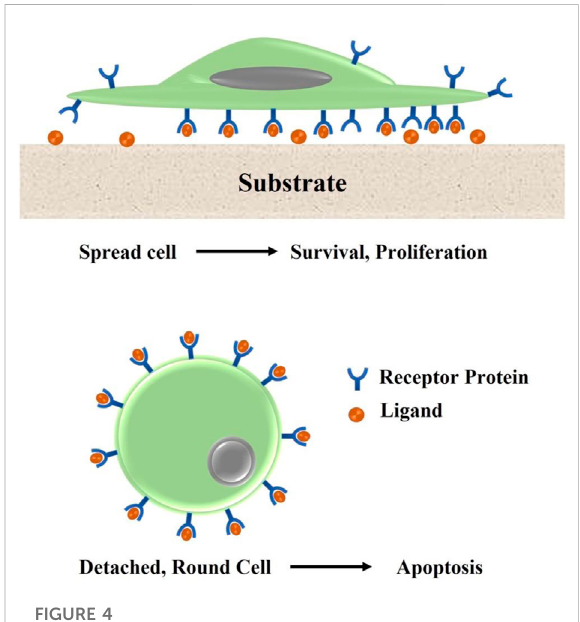
FIGURE 4 Immobilizedligandmoleculesthatfunctionasagonistsofthe ECM modify the surface. Non-immobilized ligands prevent cells from adhering to the scaffold surface, which causes